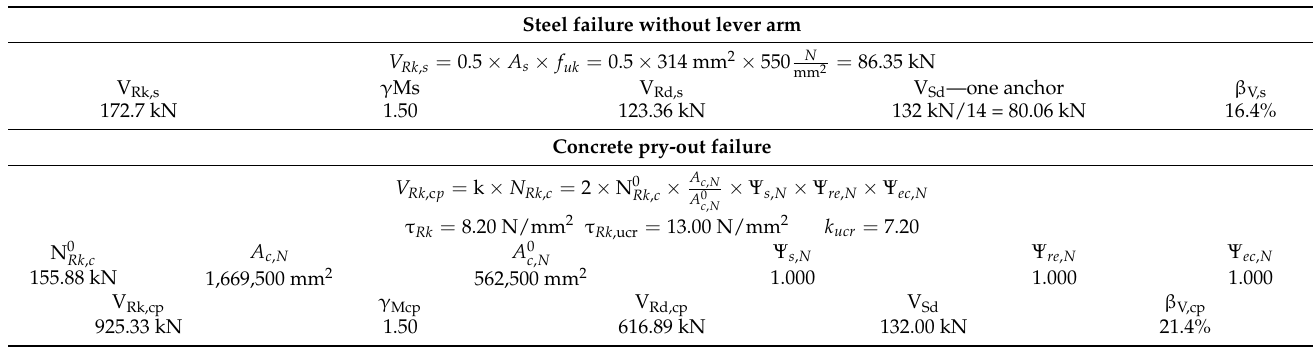
Table 3. Results of calculations of load-bearing capacity of anchorage of the rebars in the foundation slab with consideration of lateral force [18].